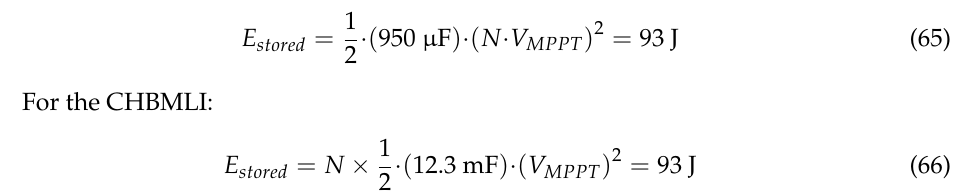
Capacitance per H-Bridge